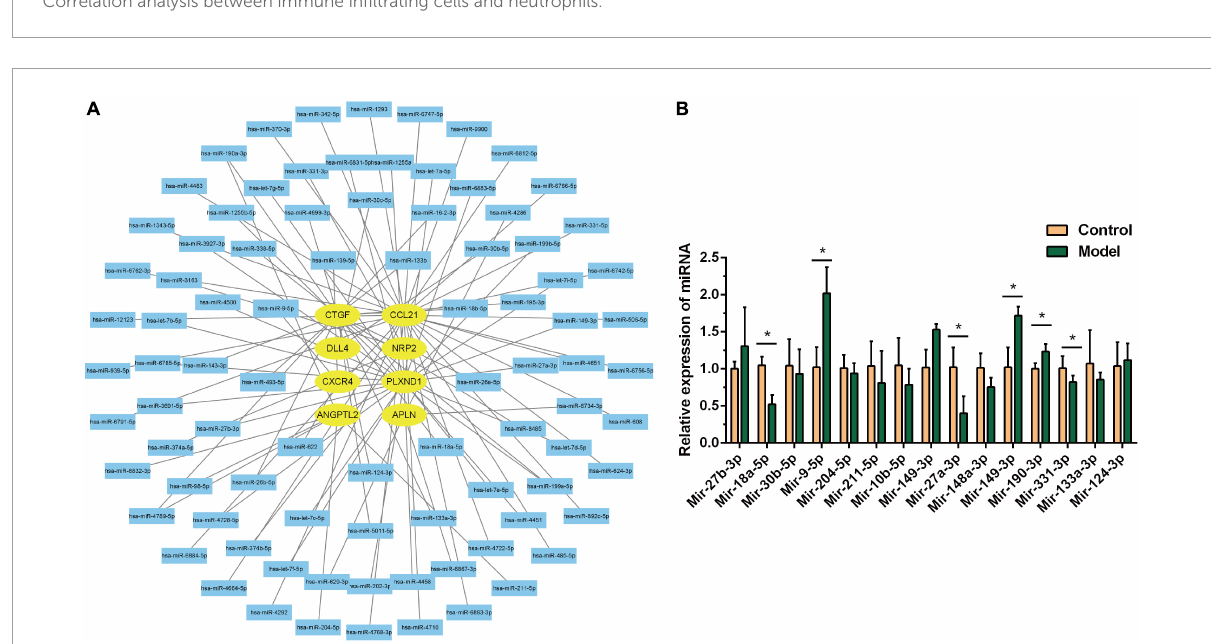
FIGURE7 MiRNA-mRNA network construction. (A) Interaction network between immune related genes and miRNA. (B) Relative miRNA expression in control group and model group. * P <